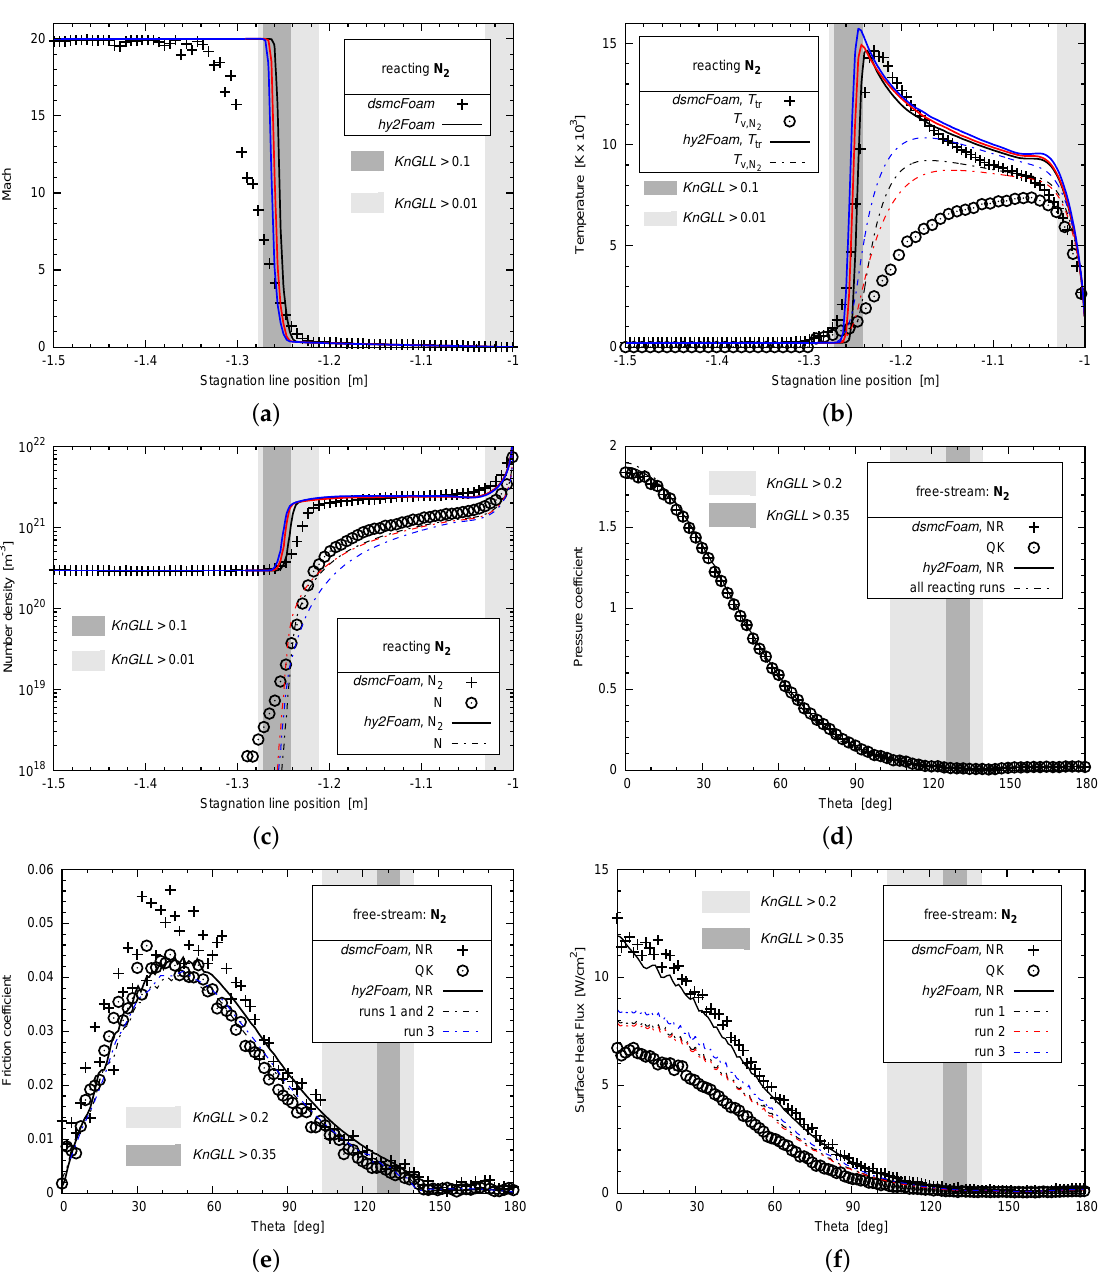
Figure 5. ( a – c ): Stagnation line profiles. CFD run 1: black lines, run 2: red lines, run 3: blue lines. ( d – f ): surface quantities around the cylinder. ( a ) Mach number; ( b ) temperature; ( c ) number density; ( d ) pressure coefficient; ( e ) skin-friction coefficient; ( f ) surface heat